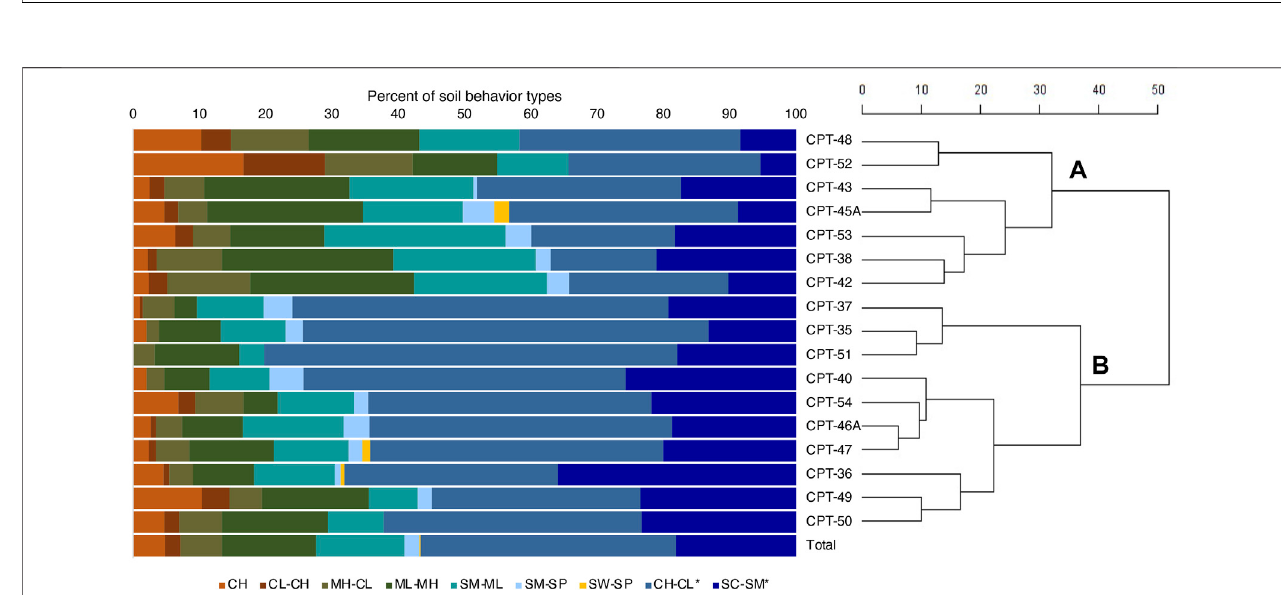
FIGURE 8 | Relative abundance of soil behavior types. Samples are ordered based on Euclidean distance calculated from composition of soil behavior types identi fi ed in each CPT log. Letters A and B on the hierarchical dendrogram on the right designate clusters A and B which differentiate primarily in the composition of compacted sediments (designated by *). Similar samples will share a branch at a lower score. Soil classi fi cations are based on Robertson (1986).